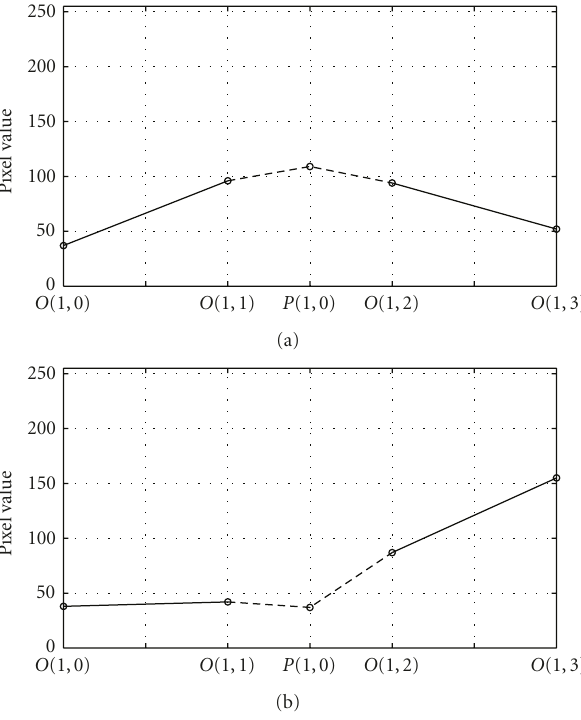
Figure 7: Two edge types for enhancement: (a) the roof edge, and (b) the ramp